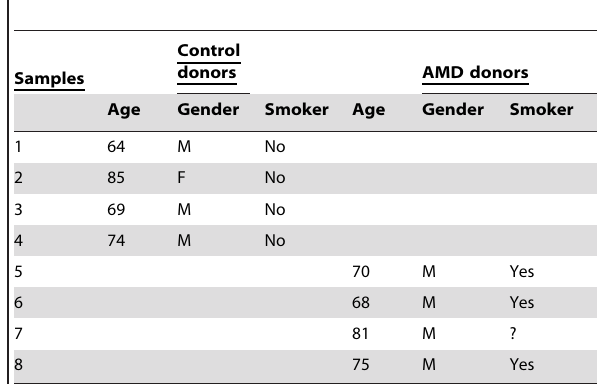
Table 1. Human Donor Eyes Information.